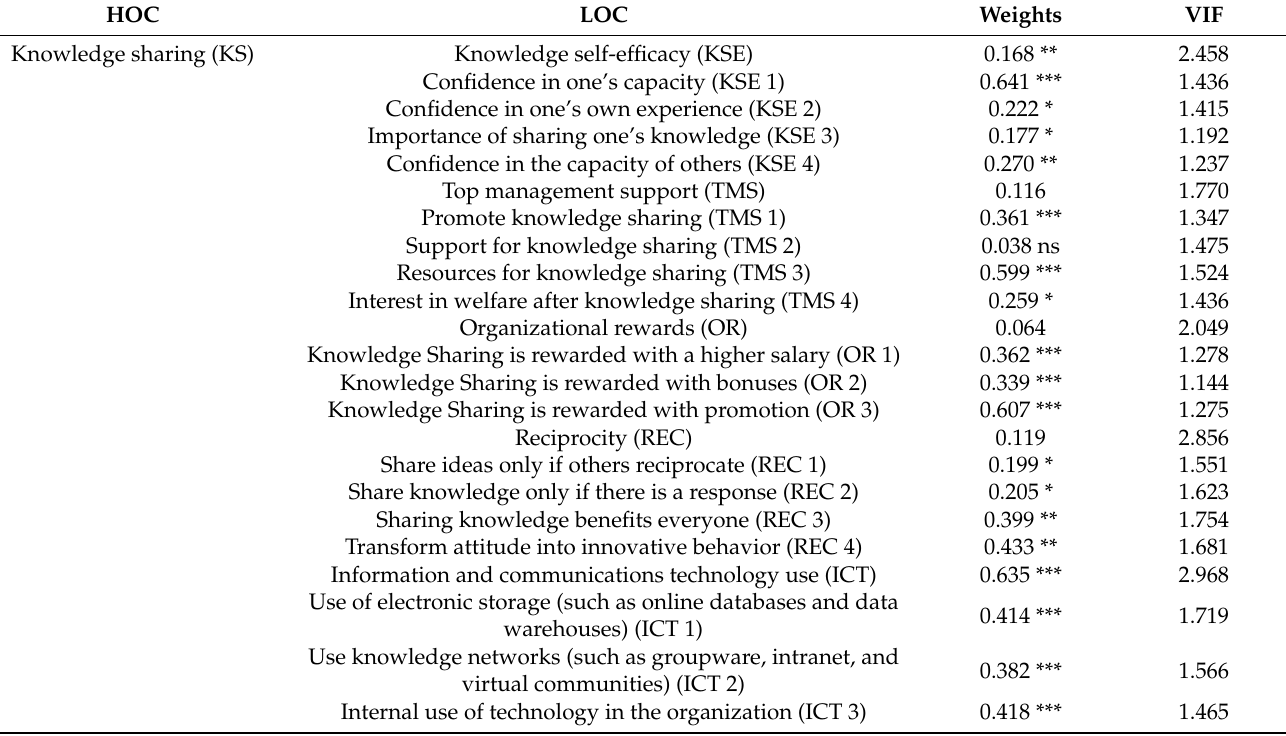
Table 1. Formative constructs and their statistical